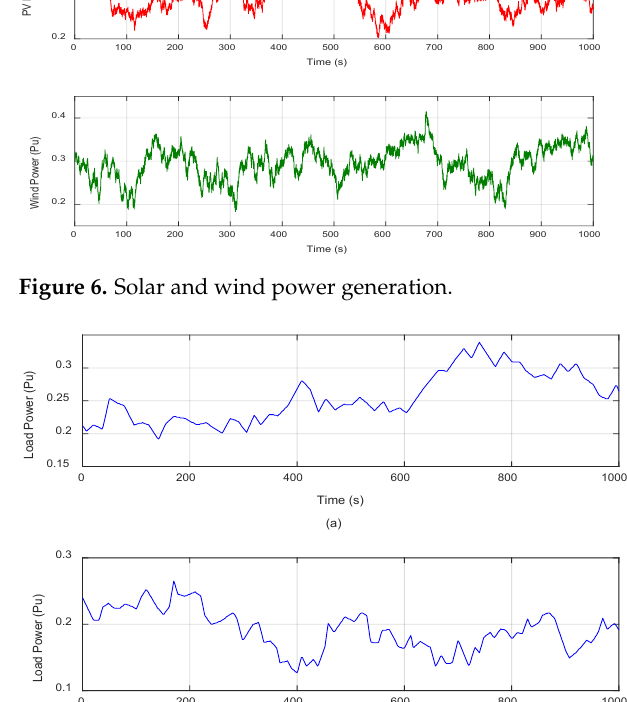
Table 3. Optimized parameters of PI controller based on WOA.